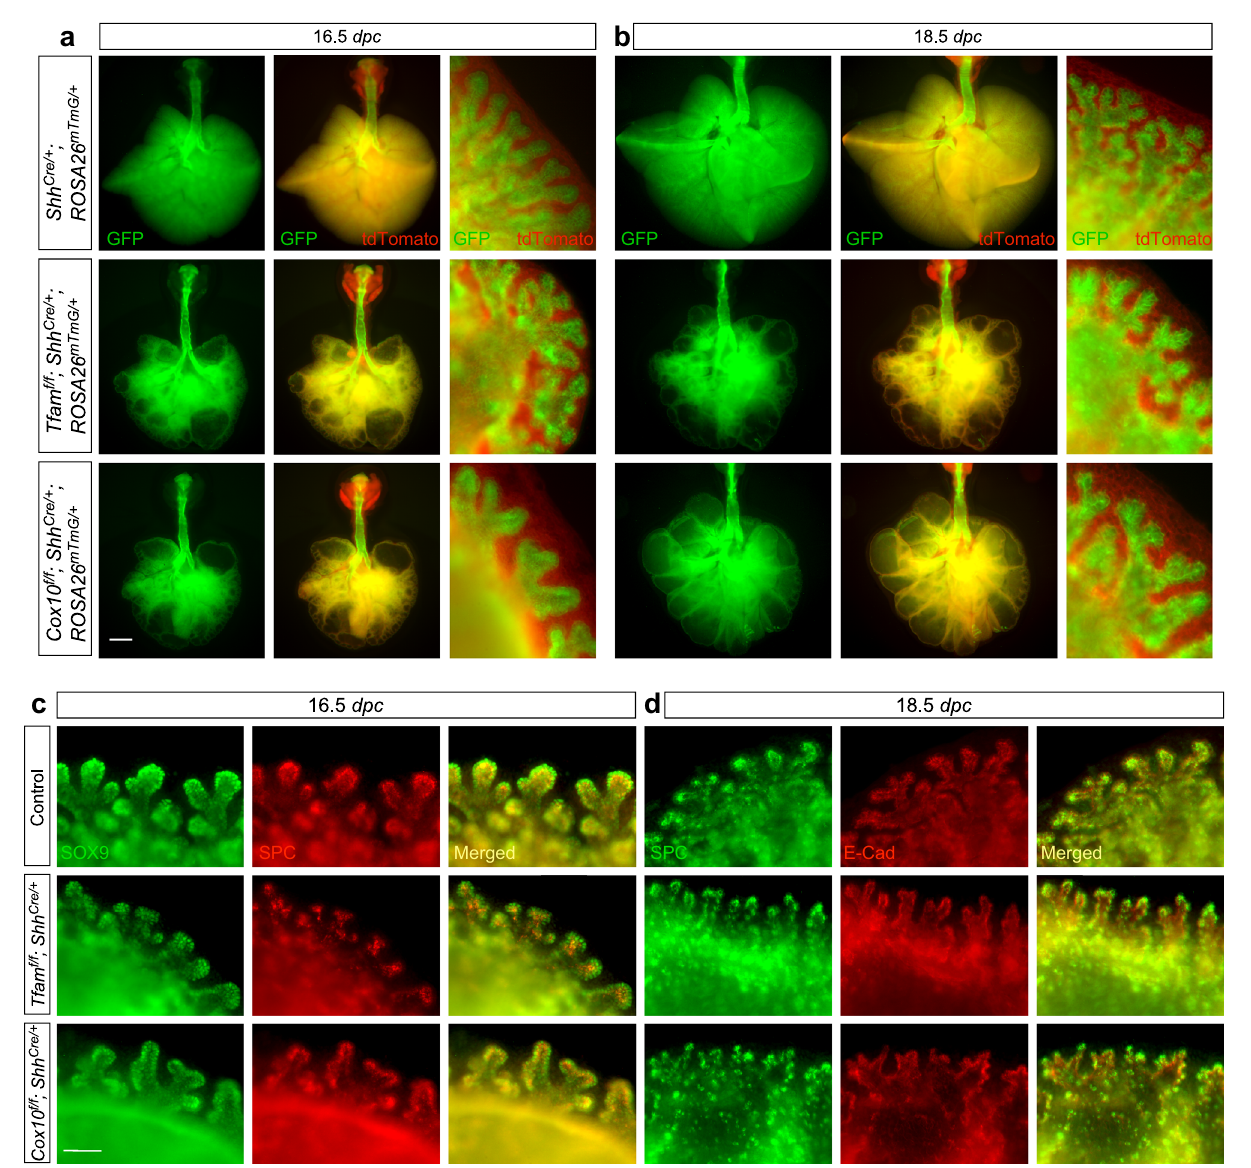
Fig. 7 | Saccular formation progresses in the absence of Tfam or Cox10